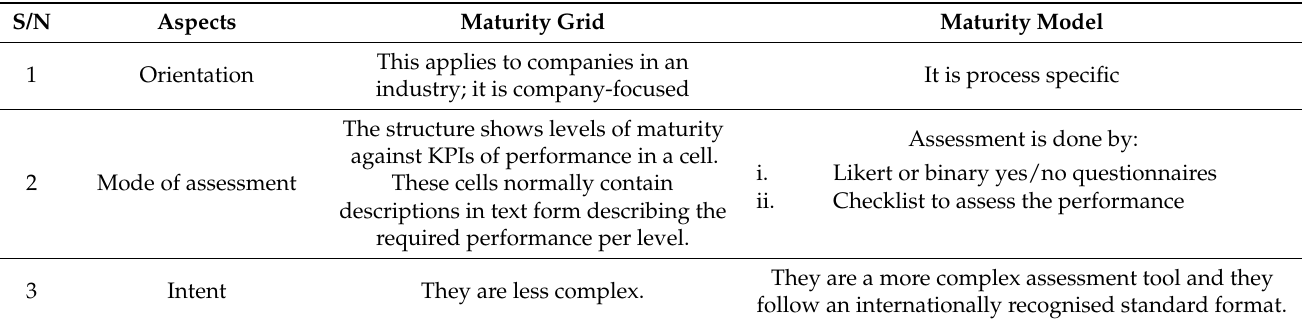
Table 1. Difference between maturity grid and maturity model